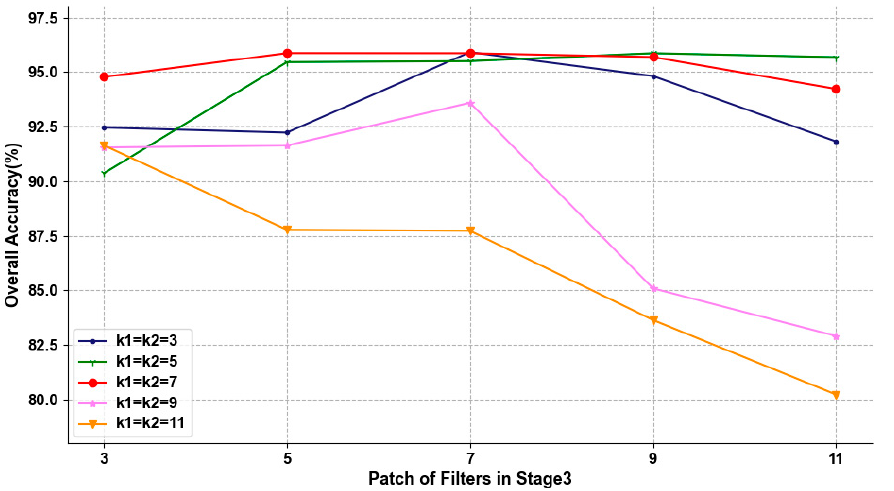
Figure 10. The influence of different filter sizes on the classification accuracy in the Baffin Bay dataset.